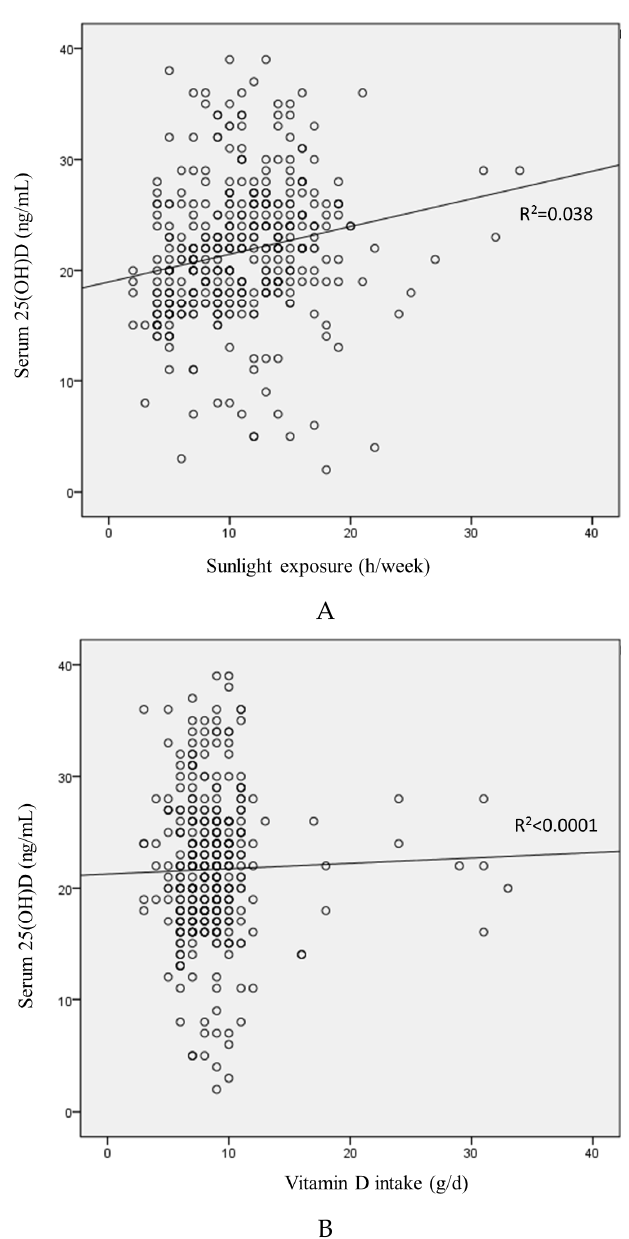
Figure 1. The plots of serum 25(OH)D, sunlight exposure ( A ) and dietary vitamin D ( B